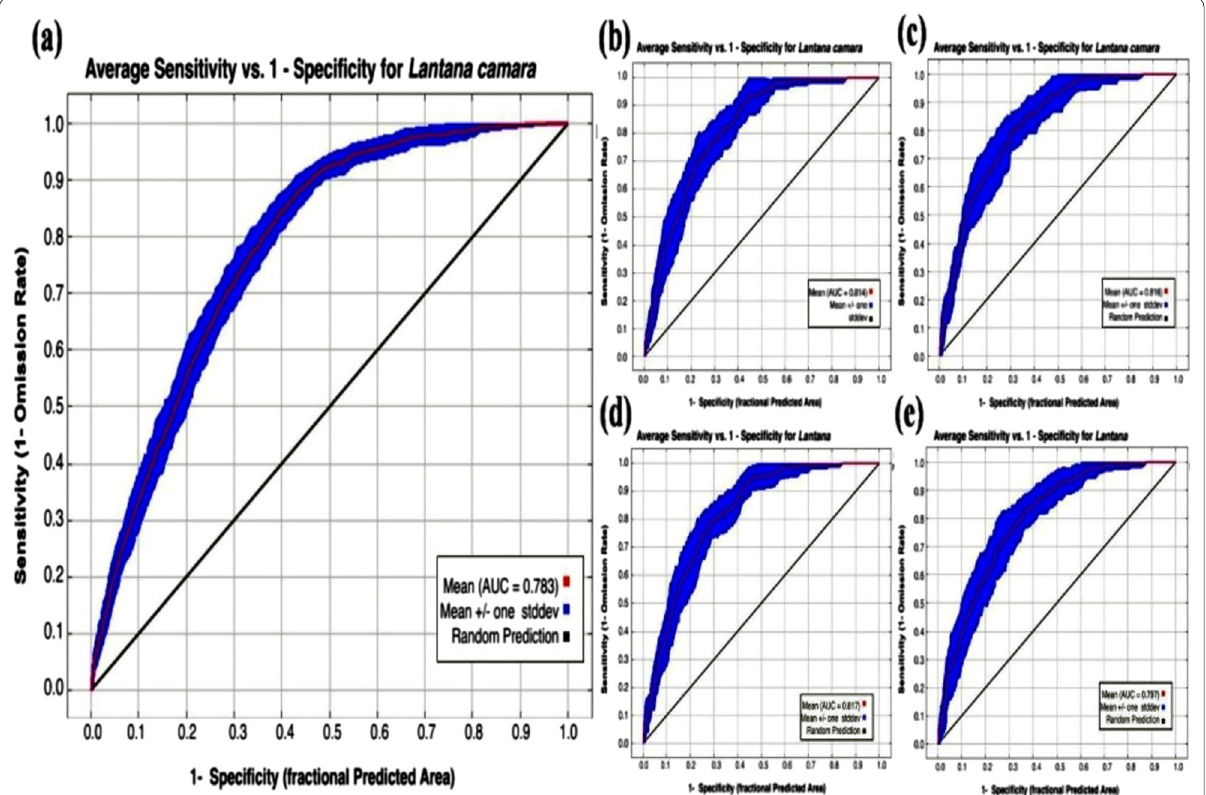
Fig. 3 AUC graph for model performance evaluation under ( a ) current scenario, ( b ) RCP 2.6, ( c ) RCP 4.5 ( d ) RCP 6.0 and ( e ) RCP 8.5 for the year